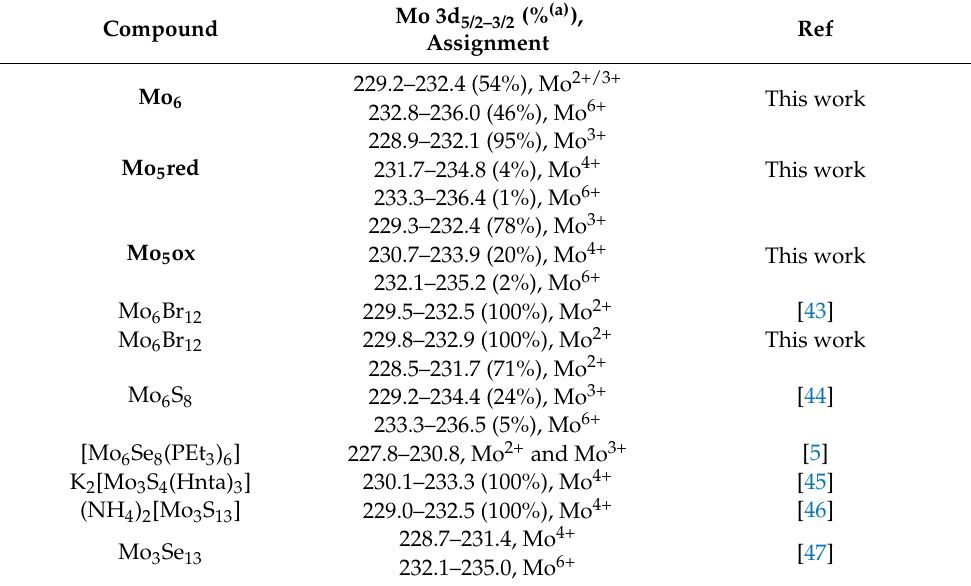
Table 3. XPS Mo 3d 5/2–3/2 binding energies (eV) in clusters obtained in comparison with literature data.